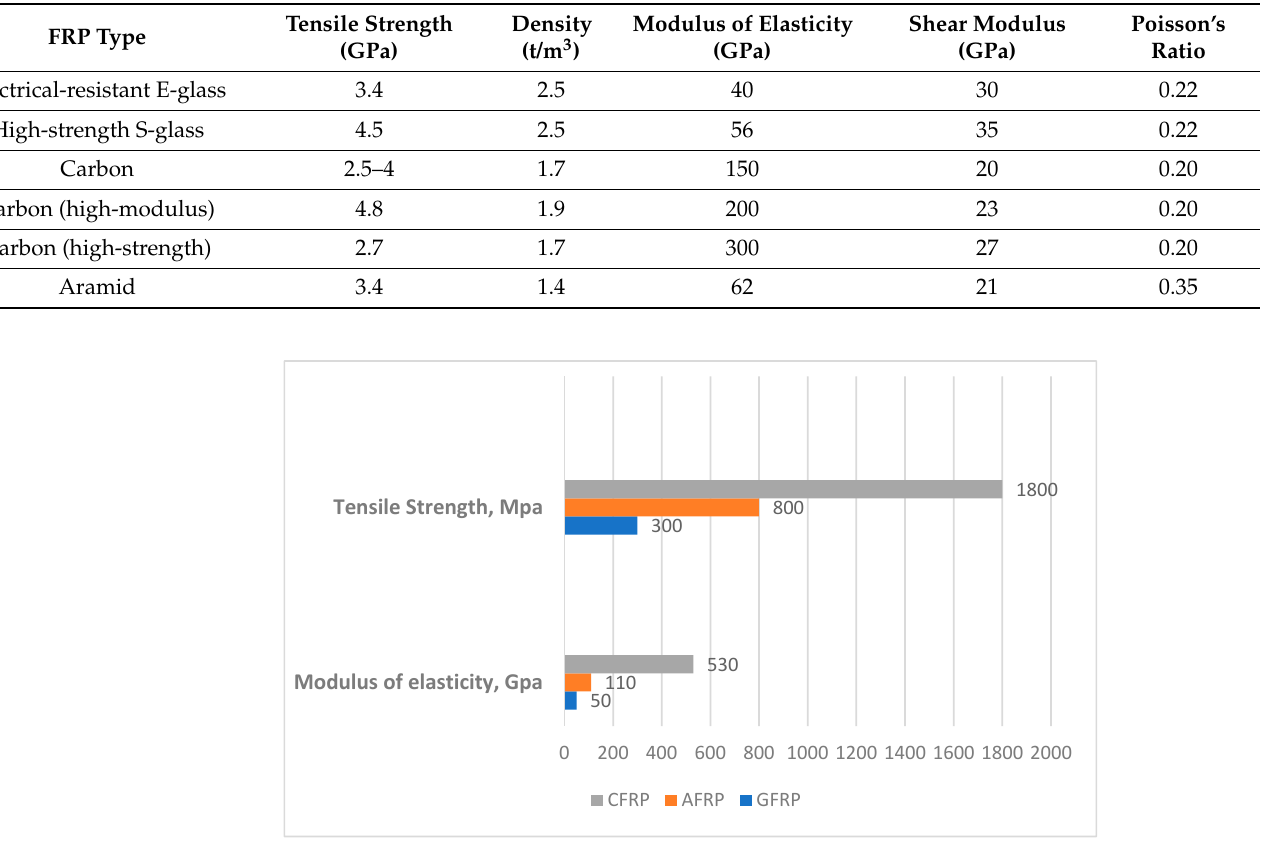
Table 1. Physical and mechanical properties of different FRPs, adapted from refs. [7,8].